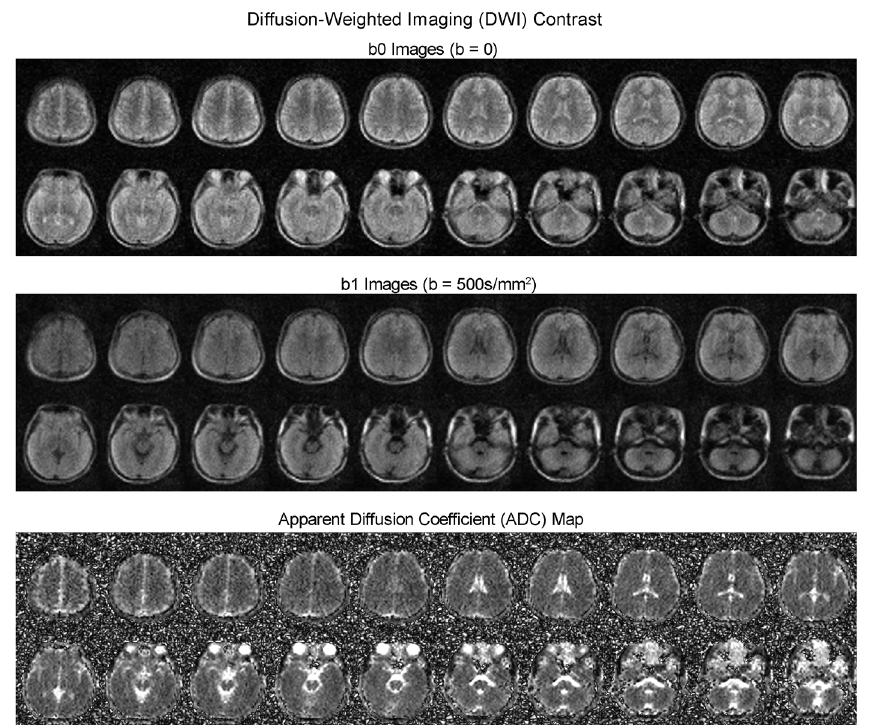
Fig. 5 Typical diffusion-weighted imaging (DWI) images (from a healthy adult) produced by the low-cost and shielding-free 0.055 T MRI scanner. Whole-brain axial sections (23 yrs. old; male) using the 2D echo-planar imaging DWI sequence with isotropic diffusion weighting factor b-value = 0 (b0 images) and 500 s/mm 2 (b1 images). Apparent diffusion coef fi cient (ADC) maps are also shown. Total scan time is 9.5 mins. All images are displayed at a spatial resolution of 1 × 1 × 5 mm 3 while the acquisition resolution is approximately 4 × 4 × 10 mm 3